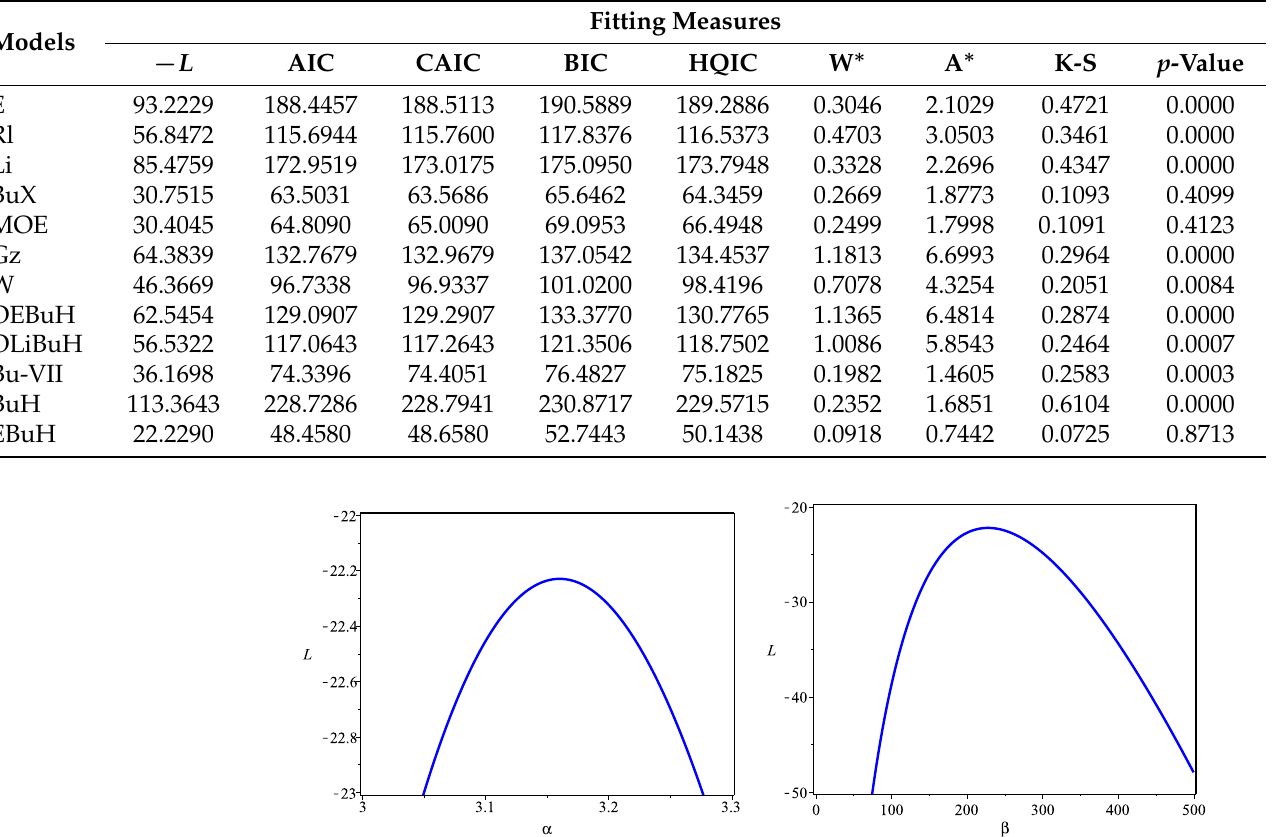
Table 8. Fitting measures of the EBuH model and other models for data set I.